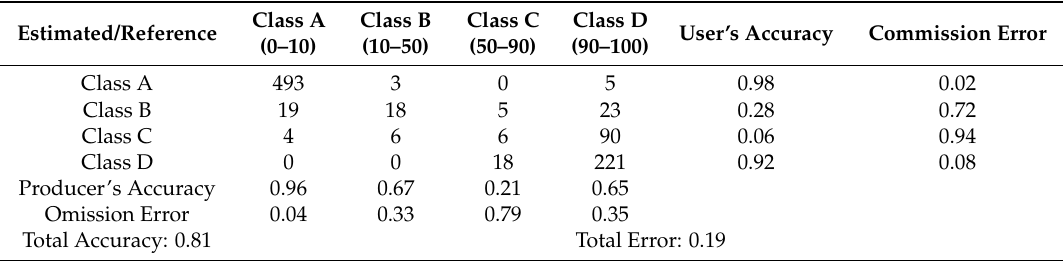
Table 8. Confusion matrices for Sodankylä wetland